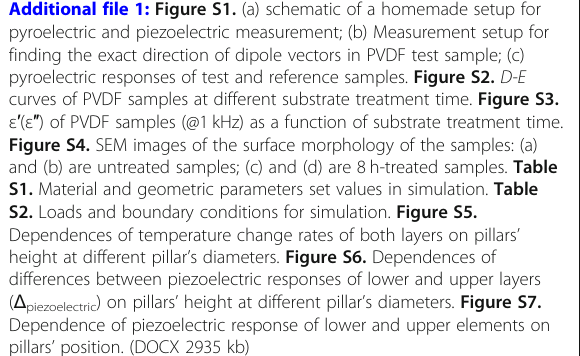
Figure S4. SEM images of the surface morphology of the samples: (a) and (b) are untreated samples; (c) and (d) are 8h-treated samples. Table S1. Material and geometric parameters set values in simulation. Table S2. Loads and boundary conditions for simulation. Figure S5. Dependences of temperature change rates of both layers on pillars ’ height at different pillar ’ s diameters. Figure S6. Dependences of differences between piezoelectric responses of lower and upper layers ( Δ piezoelectric ) on pillars ’ height at different pillar ’ s diameters. Figure S7.